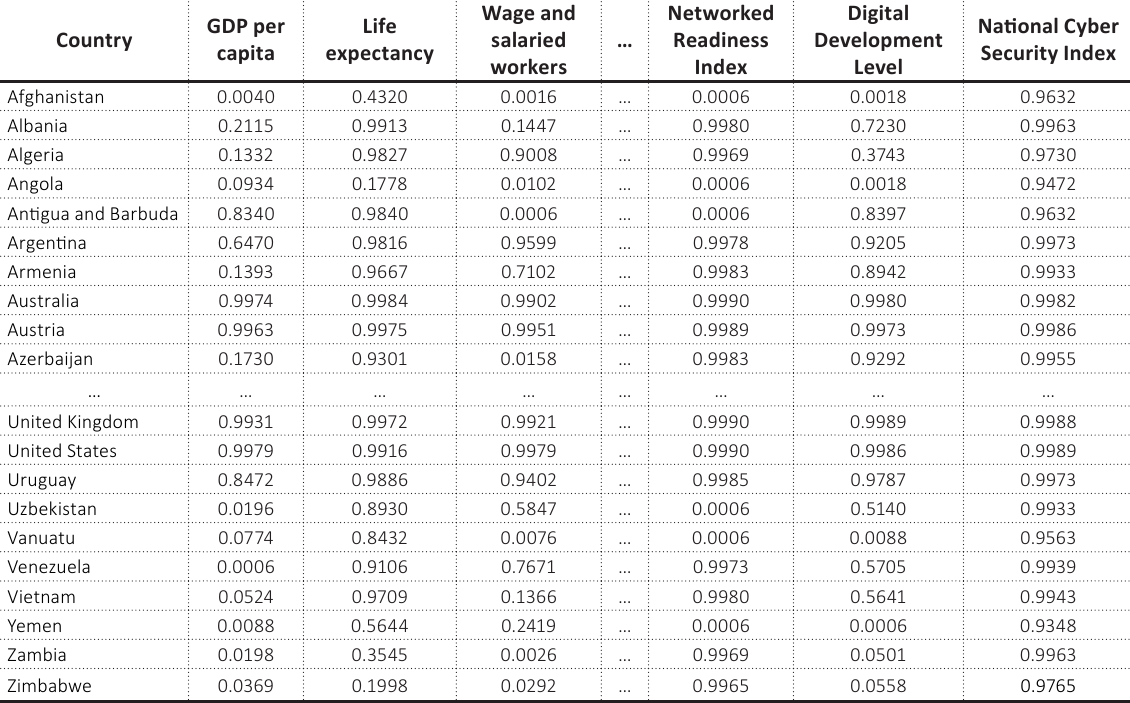
Table 5. Calculations of Harrington-Mencher transformation values (fragment)